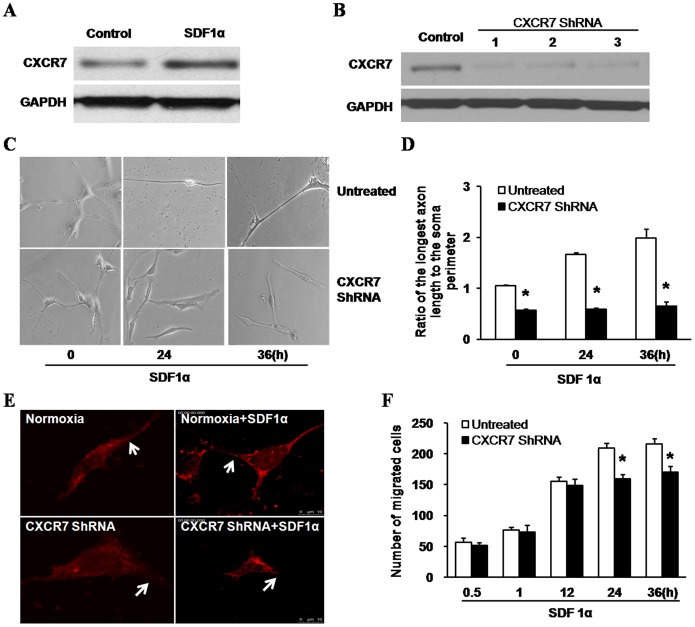
Effects of CXCR7 ShRNA on cell morphology, actin filament polymerization and migration capability induced by SDF1α in normoxic cells.A, CXCR7 expression was increased with 24 h stimulation of SDF1α. Adhered hippocampal cells were cultured in normoxia for seven days. Then cells were treated with SDF1α (50 ng/ml) for 24 h or left untreated (control). Cell lysates were obtained to detect CXCR7 expression by western blot. B, CXCR7 protein expression was determined after CXCR7 silencing. Three ShRNA (CXCR7 ShRNA1, CXCR7 ShRNA2, CXCR7 ShRNA3) lentiviral expression vectors with green fluorescent protein (GFP) were transfected into hippocampal cells targeting CXCR7 mRNA on the 7th day of culture. Three days later, cell lysates of transfected and untreated cells (control) were obtained to determine CXCR7 protein expression by western blot. The lentivirus-GFP that expressed GFP only was used as a blank control (data was not shown). Here, we used CXCR7 ShRNA1 as an effective inhibitor to do subsequent experiments. C, D, Cell morphology was observed and the ratio of the longest axon length to the soma perimeter was calculated by image analysis system. Cells were cultured under normoxia with or without CXCR7 ShRNA transfection followed by SDF1α (50 ng/ml) for 24 or 36 hours, or left untreated. Neuronal cells were counted under a light microscope. Six predetermined areas in each independent well (From a total of six wells) at each time point were selected and photographed. Then the longest axon length and the soma perimeter were counted and calculated manually. Bar = 10 µm. *P<0.01, vs untreated. E, Actin filament polymerization was observed by staining with phalloidin and imaging with confocal microscopy. Neural cells were transfected with CXCR7 ShRNA with following SDF1α (50 ng/ml) application for 24 h or not. Arrows indicate the distribution changes of actin filament polymerization. Bar = 10 µm. F, Number of migrated cells was counted by transwell chamber analysis. Some of cells were transfected with CXCR7 ShRNA, and some were left untreated. Then cells were placed in the upper chamber and SDF1α (50 ng/ml) was added to the lower chamber for 0.5, 1, 12, 24, and 36 hours respectively for migration analysis. *P<0.01, vs untreated.